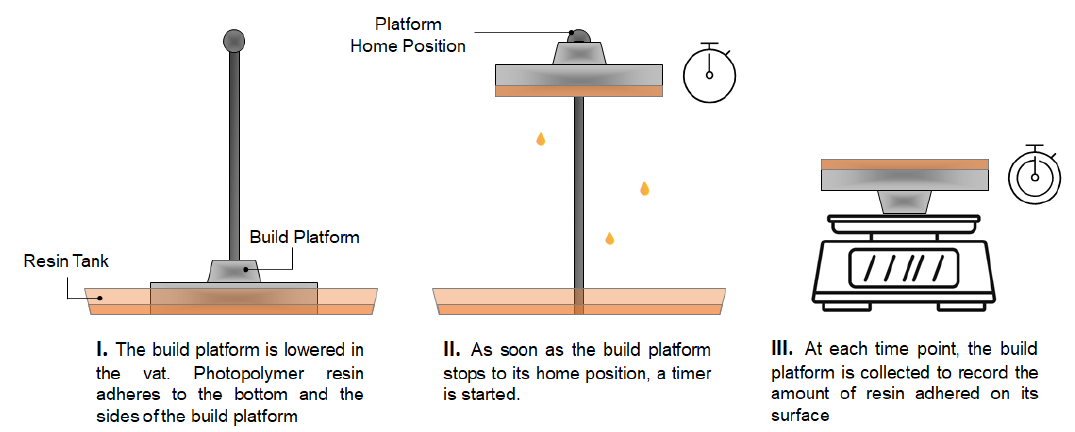
Figure 2. Schematic diagram of the method developed to evaluate photopolymer resin wastage due to adherence on the build platform at the completion of a print.